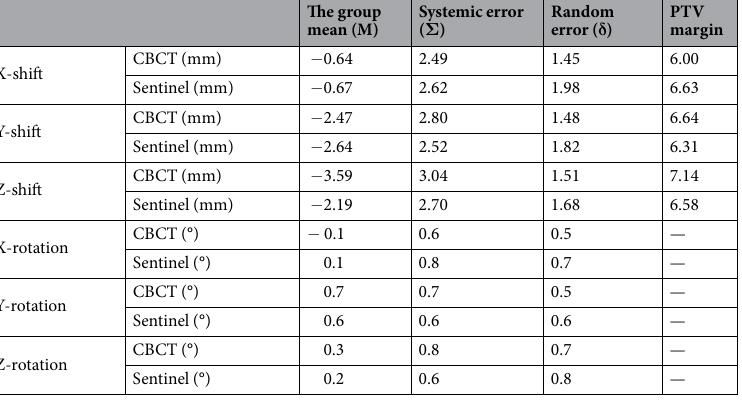
Table 2. Setup error of CBCT and sentinel before moving the treatment table. CBCT: cone-beam computerized tomography.